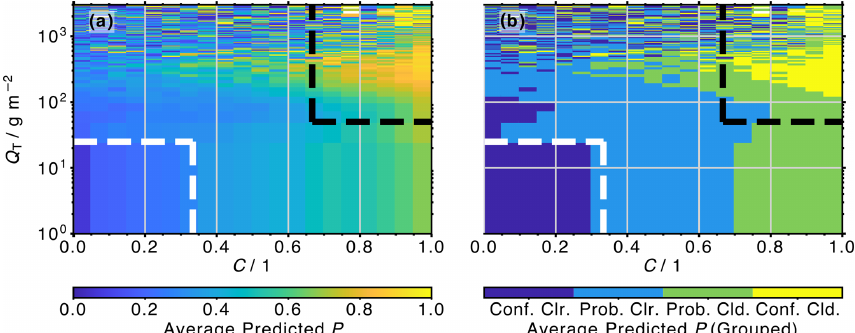
Figure 6. (a) Average probability of cloudiness ( P ) predicted by the ANN as a function of C and Q T . No restrictions on cloud top pressure ( p CT ) are imposed. (b) Same as (a) , but P is grouped into four classes: confidently clear (“Conf. Clr.”; P < 0 . 25), probably clear (“Prob. Clr.”; 0 . 25 ≤ P < 0 . 5), probably cloudy (“Prob. Cld.”; 0 . 5 ≤ P < 0 . 75), and confidently cloudy (“Conf. Cld.”; P ≥ 0 .